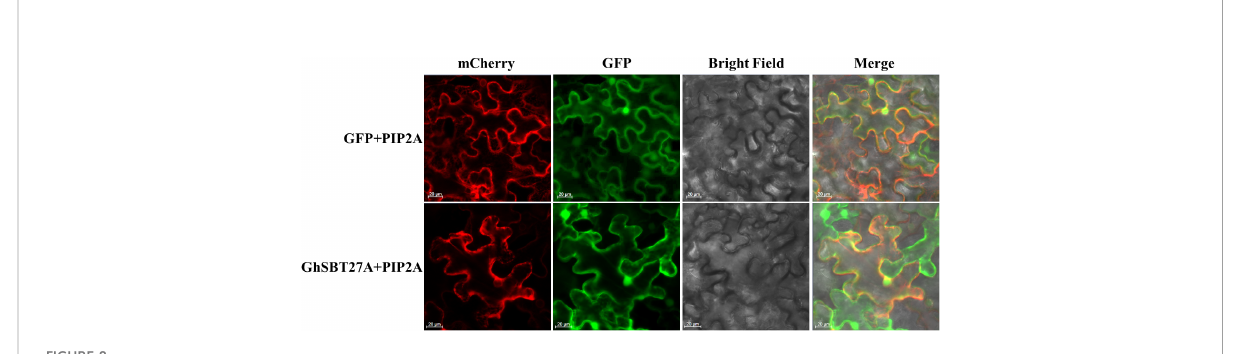
FIGURE 8 Subcellular localization of GhSBT27A in tobacco